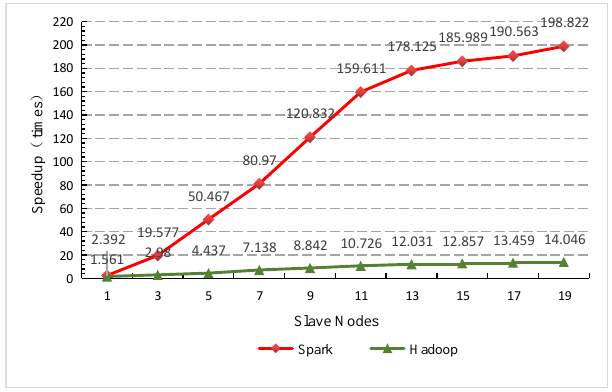
Figure 14. Comparison of speedup ratio with different node numbers.